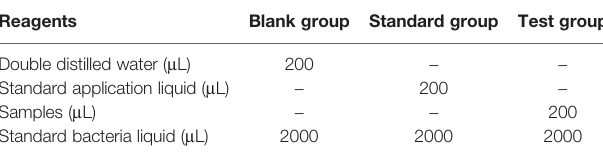
TABLE 4 | Operation table for determination of lysozyme content.